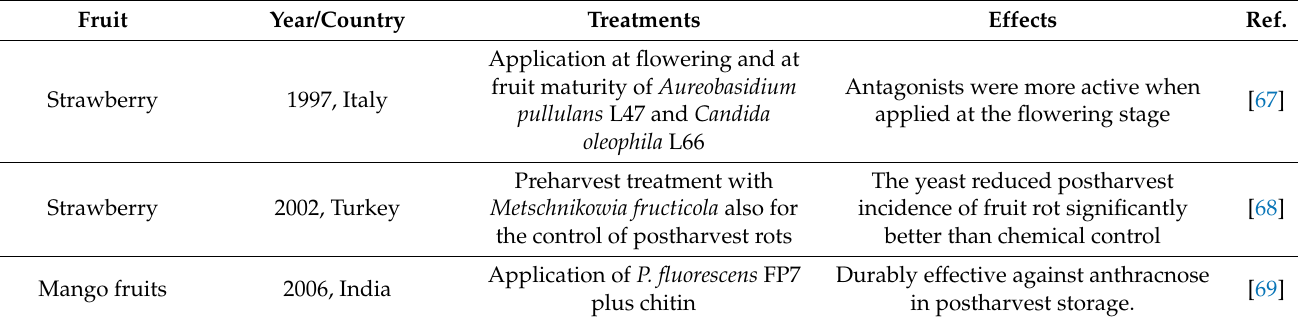
Figure 1. Pros and cons of treatments applied at different stages of plant and fruit development. Strategies include physical strategies, chemicals, biocontrol and microbe-associated molecular patterns (MAMPs). Reproduce with modification from P é triacq et al. [65].Even though a huge interest has been deserved to biocontrol both in pre- and postharvest [14], only a few studies delved into the potential protection in the storage of field microbial-based treatments (Table 2). However, the more recent trends seem to indicate rising attention to explore some of the variables that can affect the phenomenon. What appears clear considering the number of crop fruits tested, the variability of microbial agents (species), the different timing/modality of application, and the target monitored to evaluate the postharvest effect (Table 2), it crucial to improve harmonisation in the research activities to steer and promote the innovation in this field. Table 2. Examples of microorganisms (for biological control) applications in preharvest tested to achieve positive effects (also) in